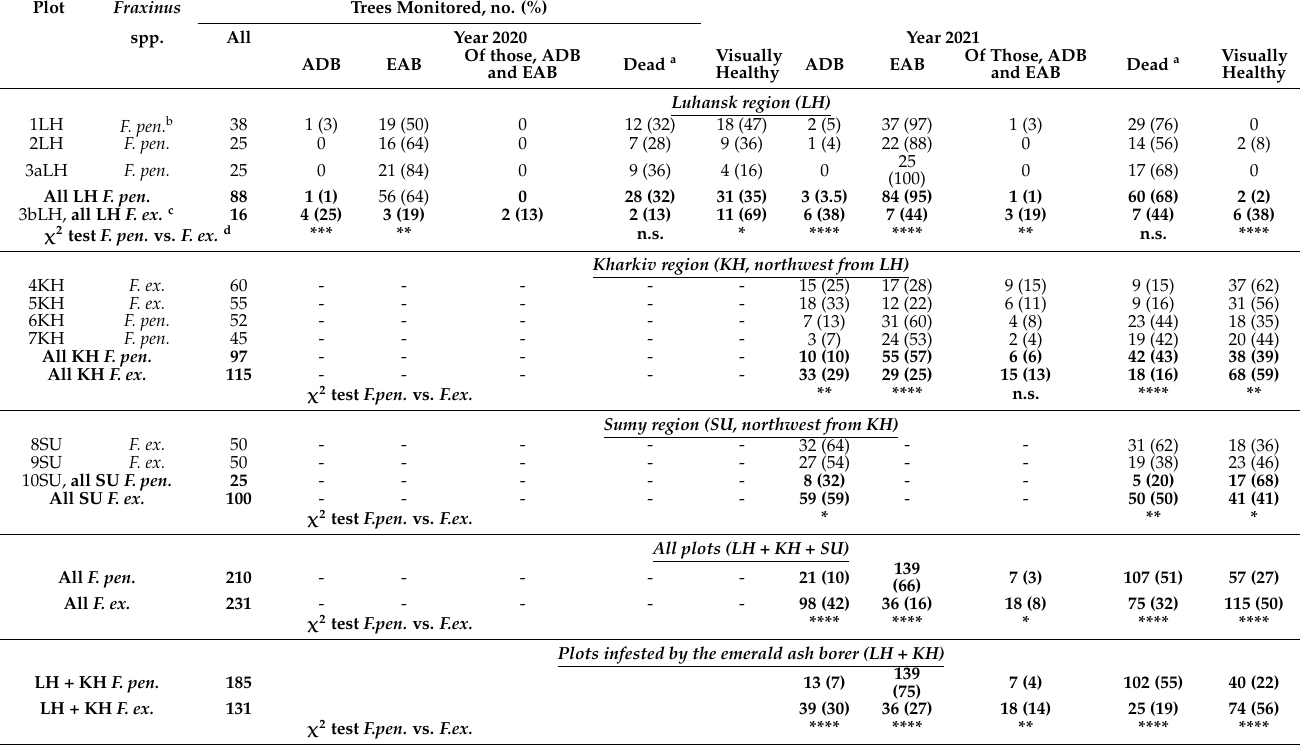
Table 1. Infestations of the ash dieback disease fungus Hymenoscyphus fraxineus (ADB) and emerald ash borer Agrilus planipennis (EAB) on Fraxinus pennsylvanica and F. excelsior trees in eastern Ukraine. The plots are as shown in Figure 1.